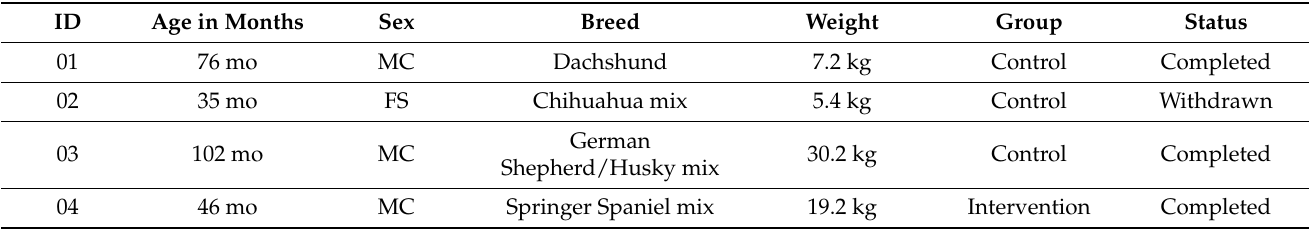
Table 1. Subject signalment, group, and study completion status (MC = male, castrated; MI = male, intact; FS = female, spayed; FI = female,